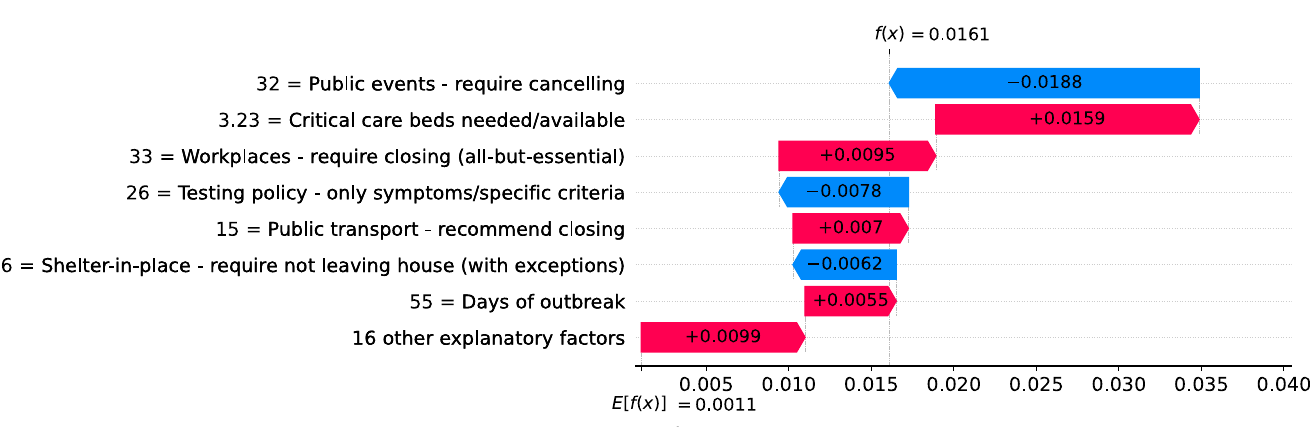
Fig 10. (Color online) waterfall plots for Italy. Factors driving acceleration on the 27 th